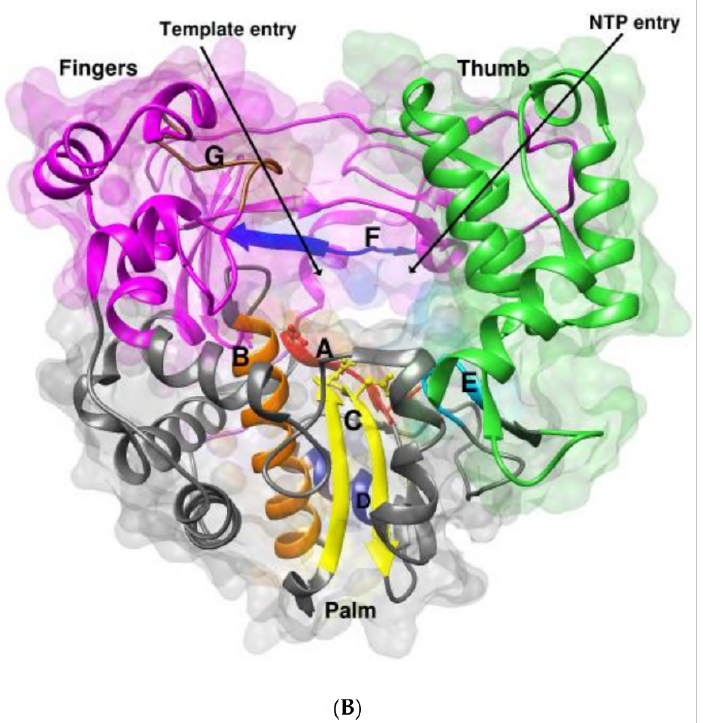
Figure 1. ( A ) Polymerization reaction catalyzed by RdRP. ( B ) The structure of poliovirus RdRP (PDB 1RA6) showing the fingers (magenta ribbon), palm (gray), and thumb (green) subdomains. The motifs A (red), B (orange), C (yellow), D (navy blue), E (cyan), F (blue), and G (brown) are indicated. The aspartates involved in catalysis from motifs A and C are shown. The conserved aspartates of the motif A (D-x(4,5)-D) and motif C (GDD) are represented as ball-and-stick, and the main channels are indicated.